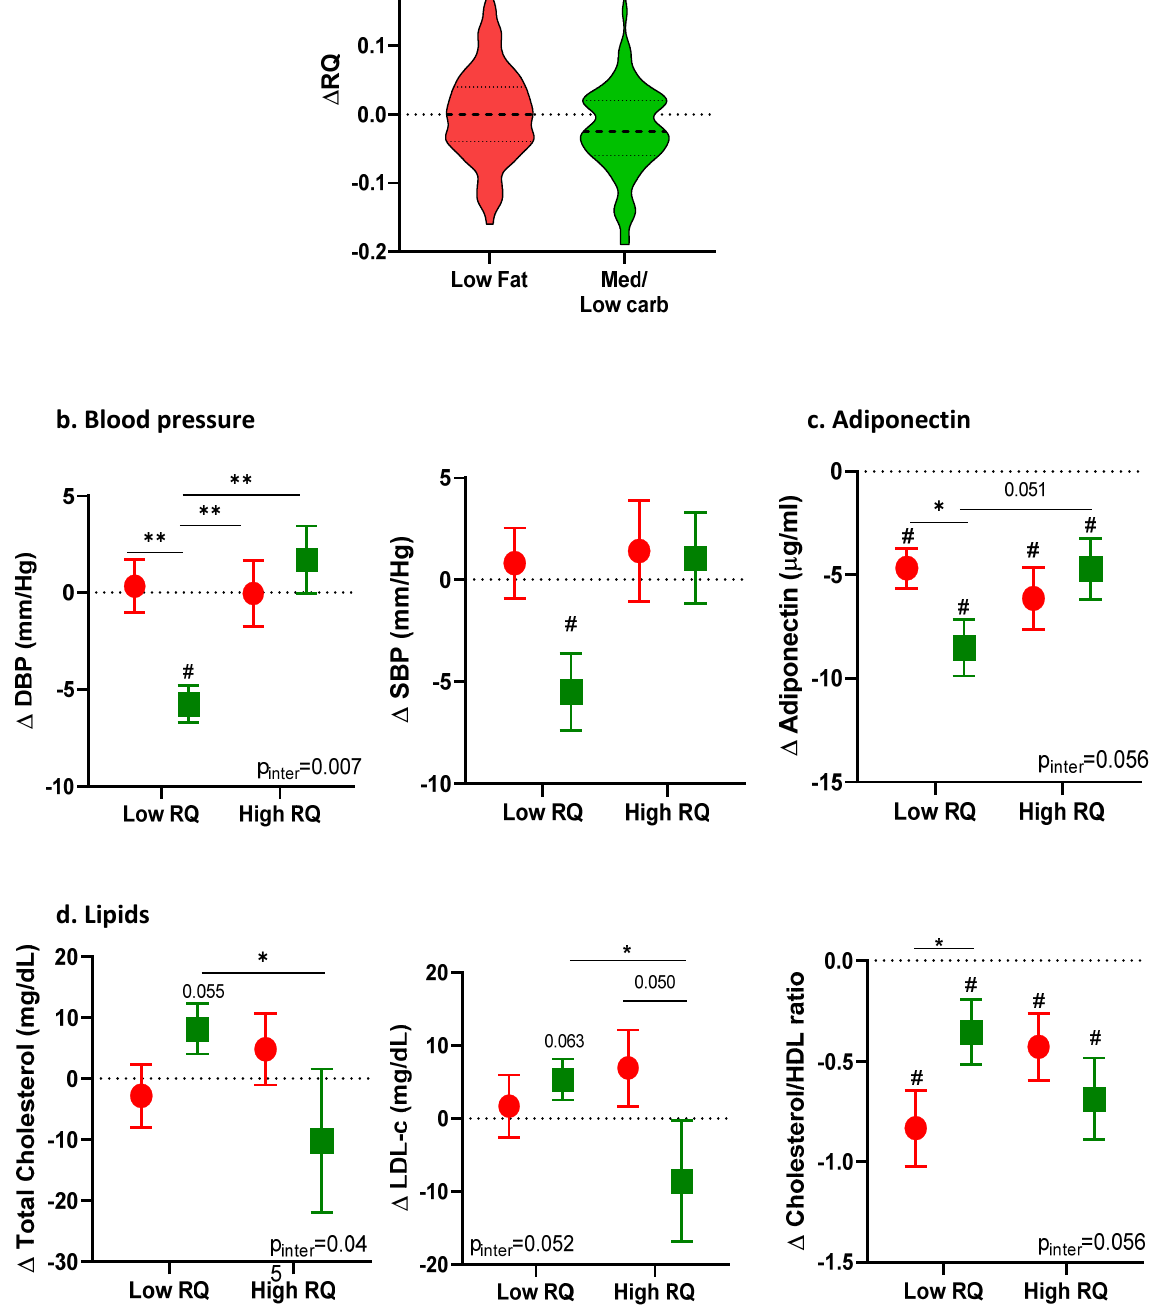
Figure 3. ( a ) RQ changes after 6 months intervention across diet groups. ( b – d ) Changes in cardiometabolic parameters and adiponectin across RQ levels stratification and diet groups. ( n = 159). Stratification was calculated following a significant or a trend in a two-way ANOVA analysis that included diet and RQ as independent variables. Significant differences between groups are represented by * p < 0.05; ** p < 0.01; # significant difference between baseline to 6 months p < 0.05.Abbreviations: DSAT—deep subcutaneous adipose tissue; DBP—diastolic blood pressure; HbA1C—Glycated hemoglobin; RQ—respiratory quotient; SBP—systolic blood pressure; SSAT—superficial subcutaneous adipose tissue; VAT—Visceral adipose tissue.